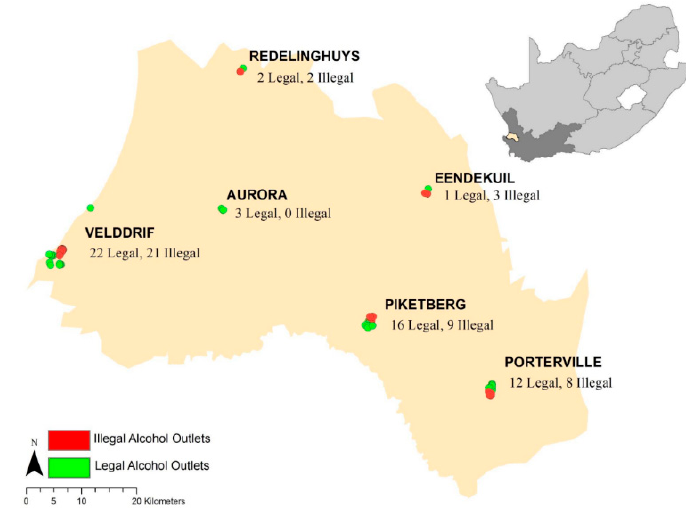
Figure 1. 2016 Study Area of collected illegal and legal alcohol outlet points.